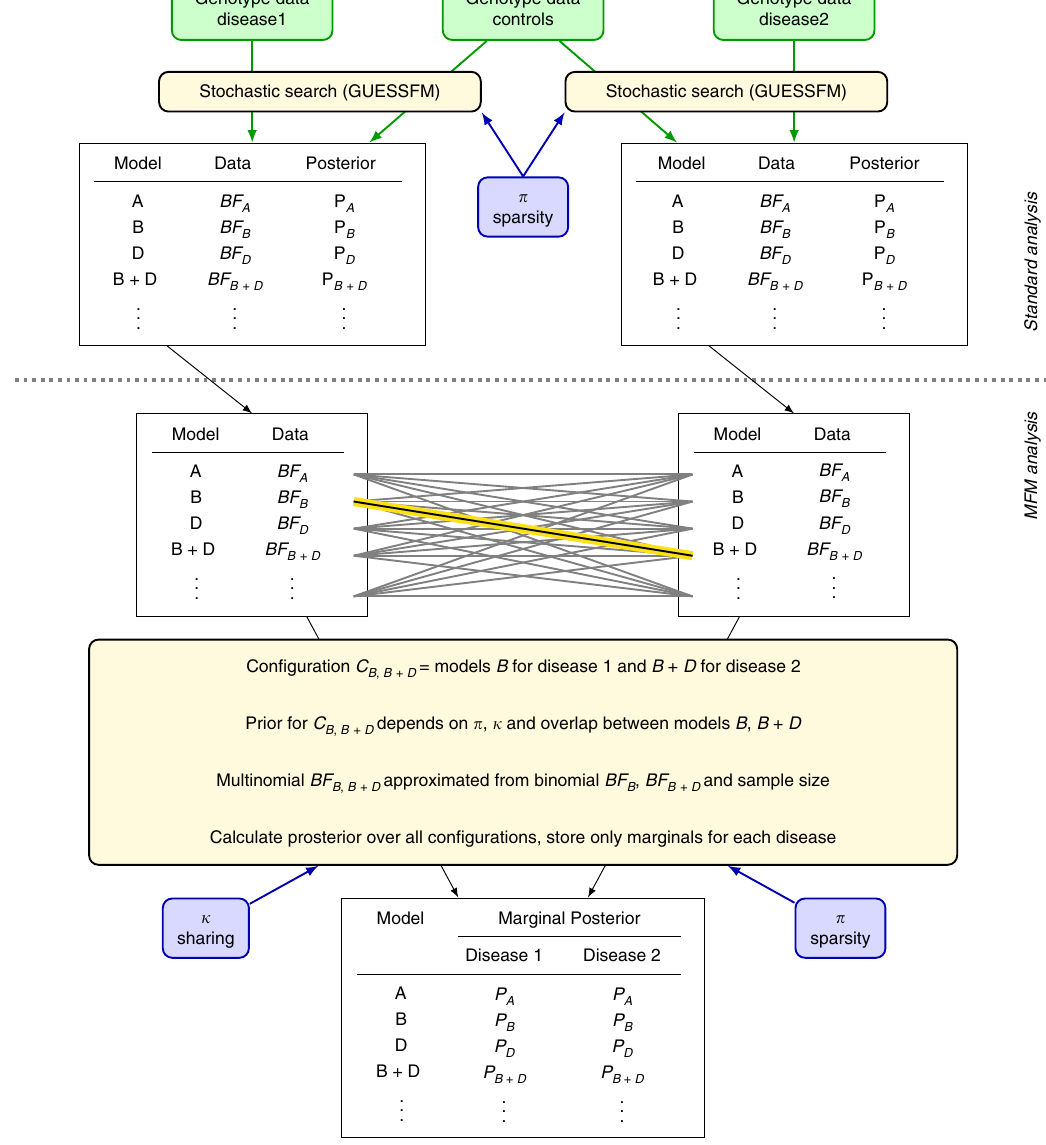
Fig. 3 Schematic diagram for Multinomial Fine-Mapping (MFM) method. MFM is used for multiple diseases with shared controls and, for simplicity, only two diseases are shown. After selection of a sparsity prior parameterised by π , stochastic search is applied individually to each disease, as in standard analyses. Marginal results are combined in MFM, using an approximation to the multinomial Bayes factor (BF) and with information shared between diseases using a sharing prior, which upweights joint models with shared causal variants by a factor κ . Memory constraints are dealt with by storing only the marginal posterior distributions for each